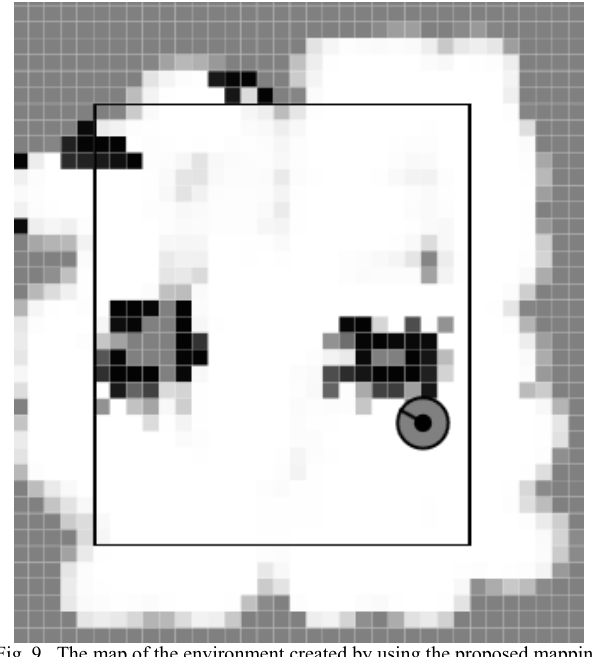
Fig. 9. The map of the environment created by using the proposed mapping approach